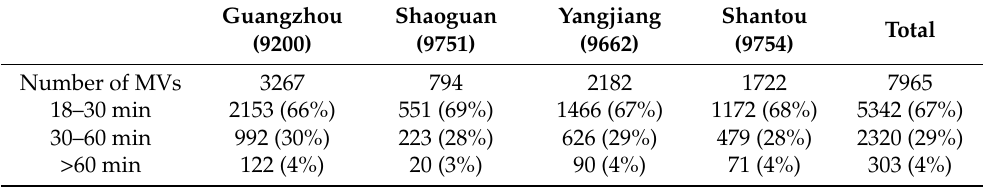
Table 1. Statistics for the number and lifetime of the MVs identified by four radars in Guangdong from April to June during 2017–2019. Percentages of the total MVs with different lifetimes are shown in